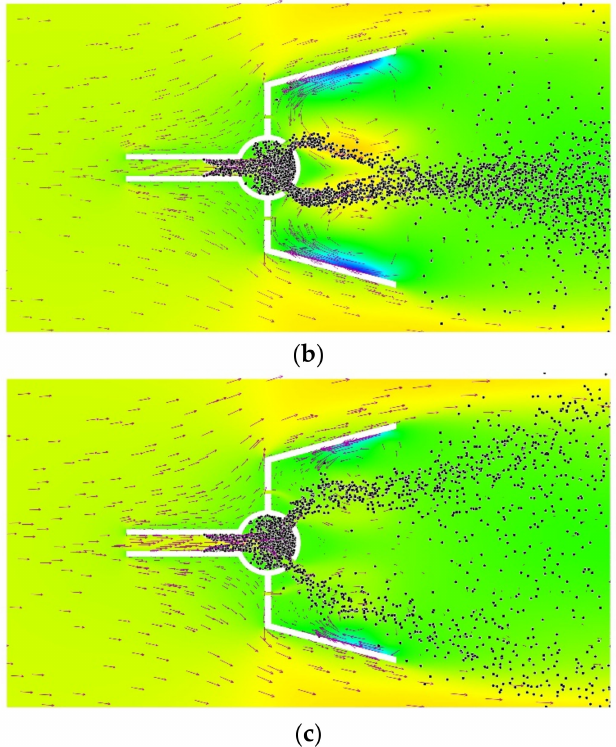
Figure 9. Spray field at different actuation dimensions: ( a ) 20 mm, ( b ) 10 mm, ( c ) 5 mm with 85 kV and 14 kHz.